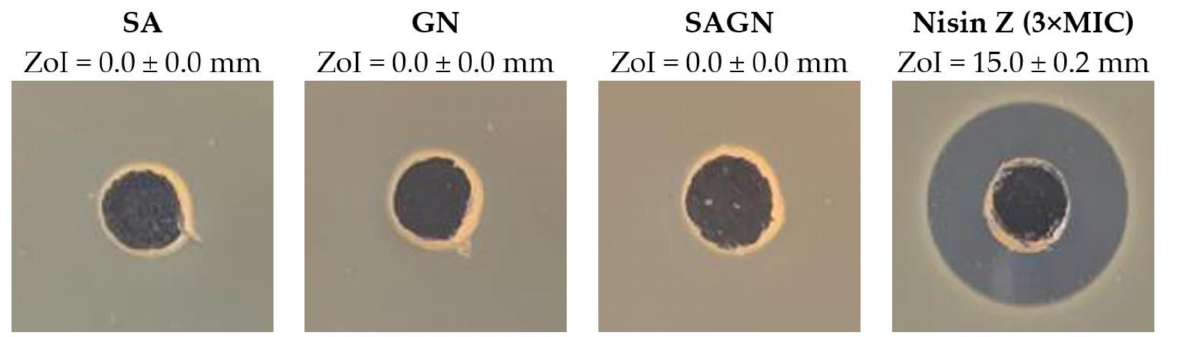
Figure 1. Zones of inhibition (ZoIs) of SA, GN, SAGN and Nisin Z against S. aureus ( n = 3, mean ± standard deviation (SD)). The diameter of the holes (Ø = 6 mm) was included in the measurement of the ZoI formed. Images were collected without regard for size proportionality, only being used as representations of the halos